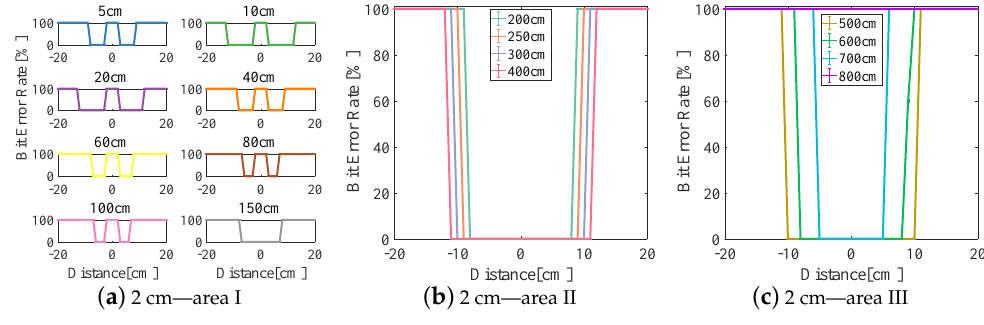
Figure 6. Lampshade height: 2 cm.